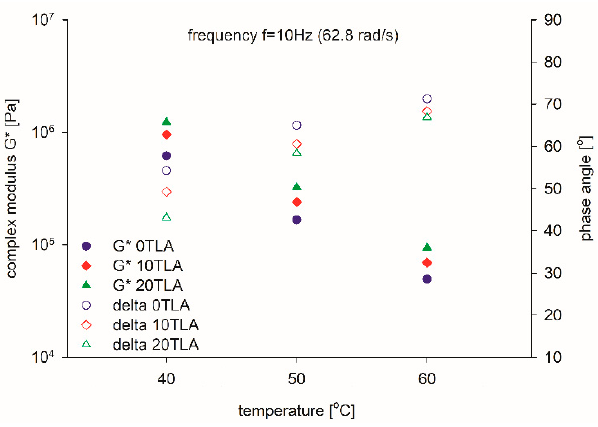
Figure 7. Complex modulus (G*) and phase angle ( δ ) of TLA-modified binders.